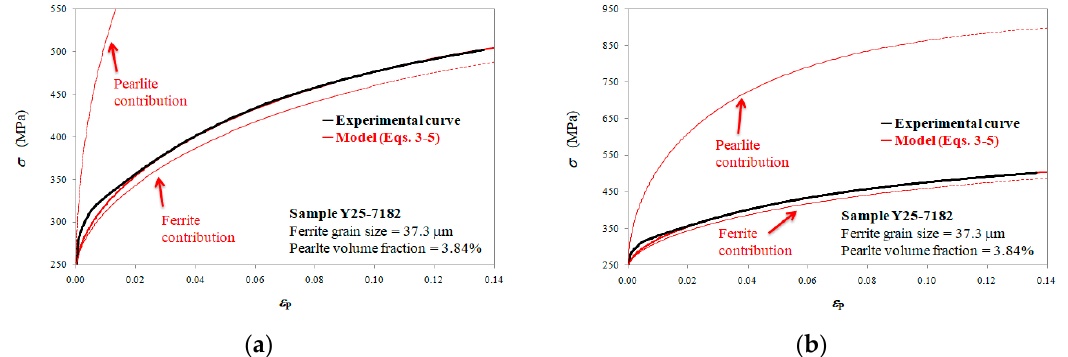
Figure 2. ( a ) Example of fitting Equation (5) with a typical tensile flow curve of GJS 400 from the Y 25 mm mould sample; ( b ) the same fitting in ( a ) at a different scale to highlight the contributions from the pearlite.